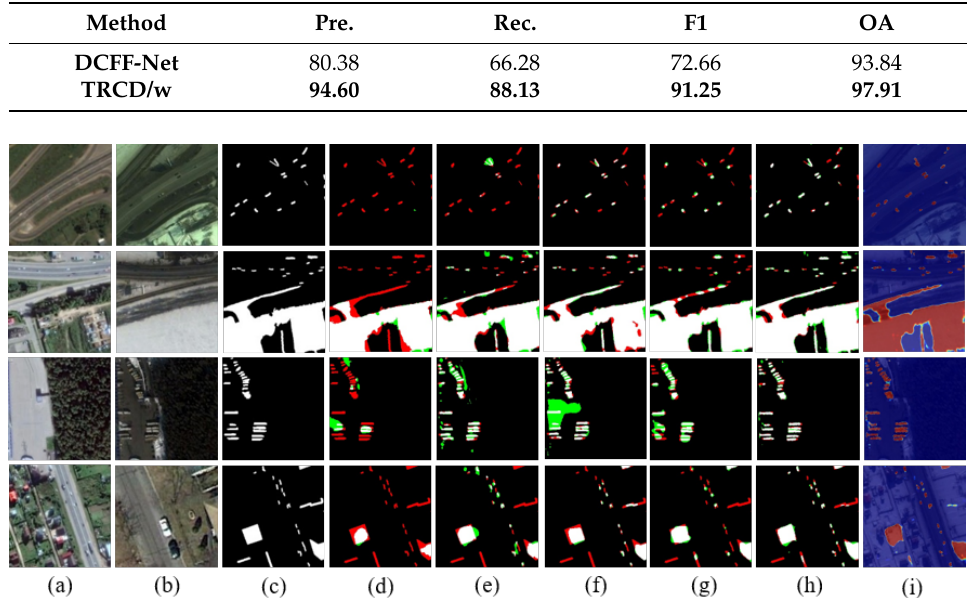
Figure 8. Qualitative comparison in terms of the detected changes from image t1 to image t2 on the CDD dataset. TP is shown in white, TN is shown in black, FP is shown in green, and FN is shown in red: ( a ) prechange, ( b ) postchange, ( c ) ground truth, ( d ) FC-siam-conc, ( e ) UNet++MSOF, ( f ) IFN, ( g ) DASNet, ( h ) our proposed model, and ( i ) attention map.